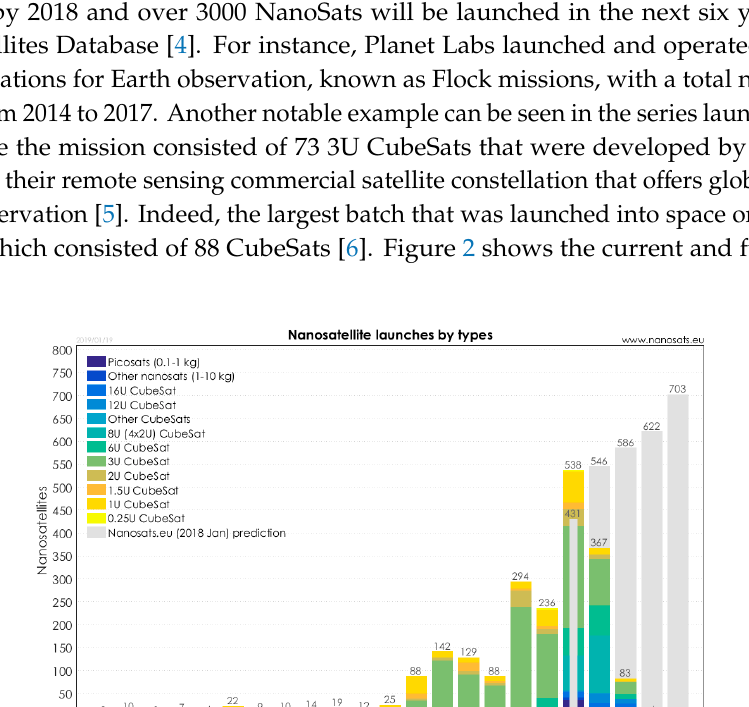
Figure 2. Nano-satellite launch by size statistics [4].